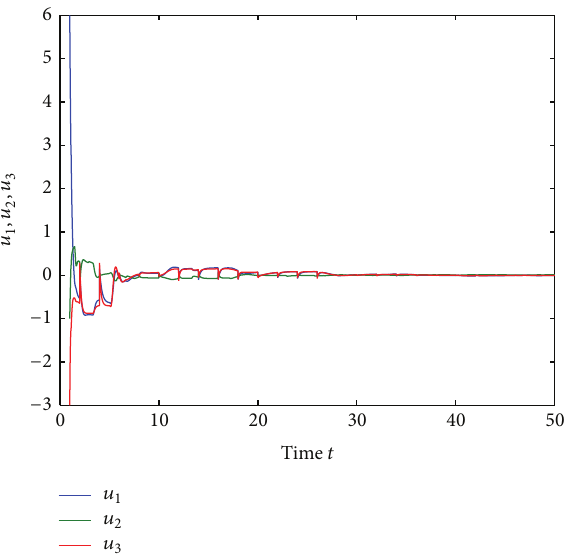
Figure1:Thesimulationforthesolutiontotheneuralnetworks(67) at the impulsive moments 2,4, 6, .. .